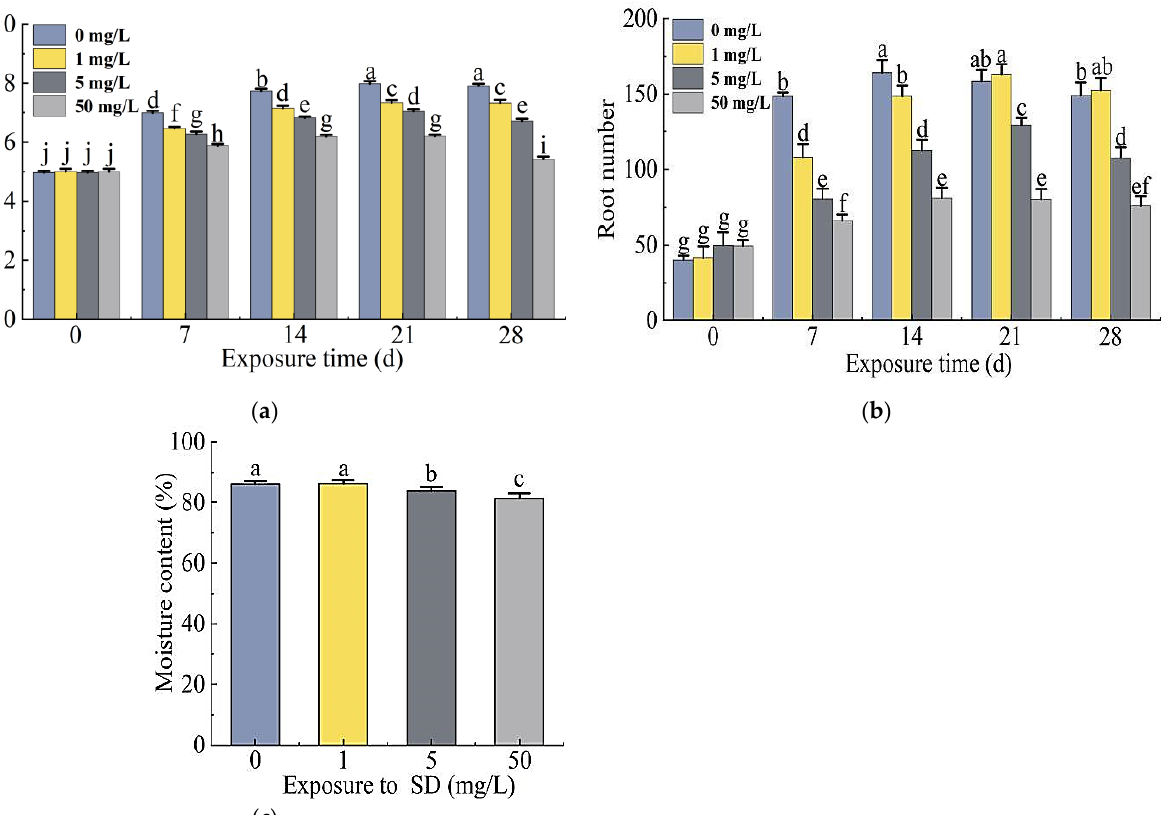
Figure 2. Differences in fresh weights ( a ), root numbers ( b ), and moisture content ( c ) of S. portulacastrum plants grown in wastewater treated with 0, 1, 5, or 50 mg/L SD for 28 days. Data are means ± standard deviation ( n = 3). Different letters above bars represent significant differences based on Duncan’s Multiple Range test at p < 0.05 level.